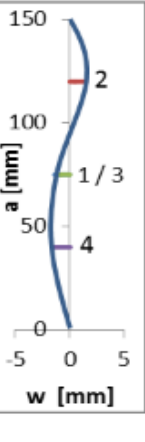
Table 2. The experimental results of load versus out-of- plane displacement for different buckling tests are shown lowest load reading of 4 LVDTs. The critical buckling